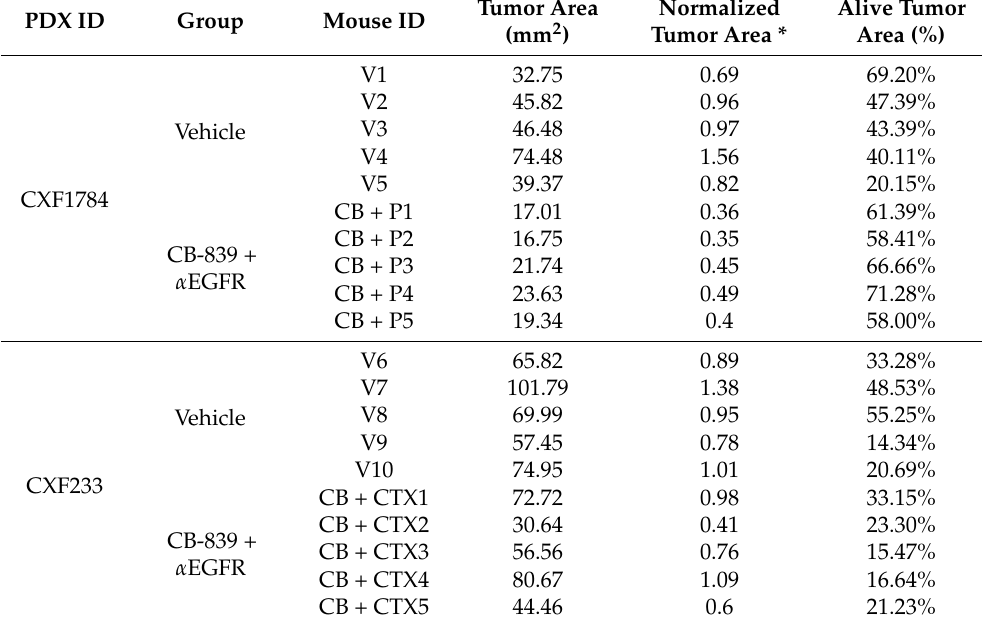
Table 2. Results of alive tumor ratio